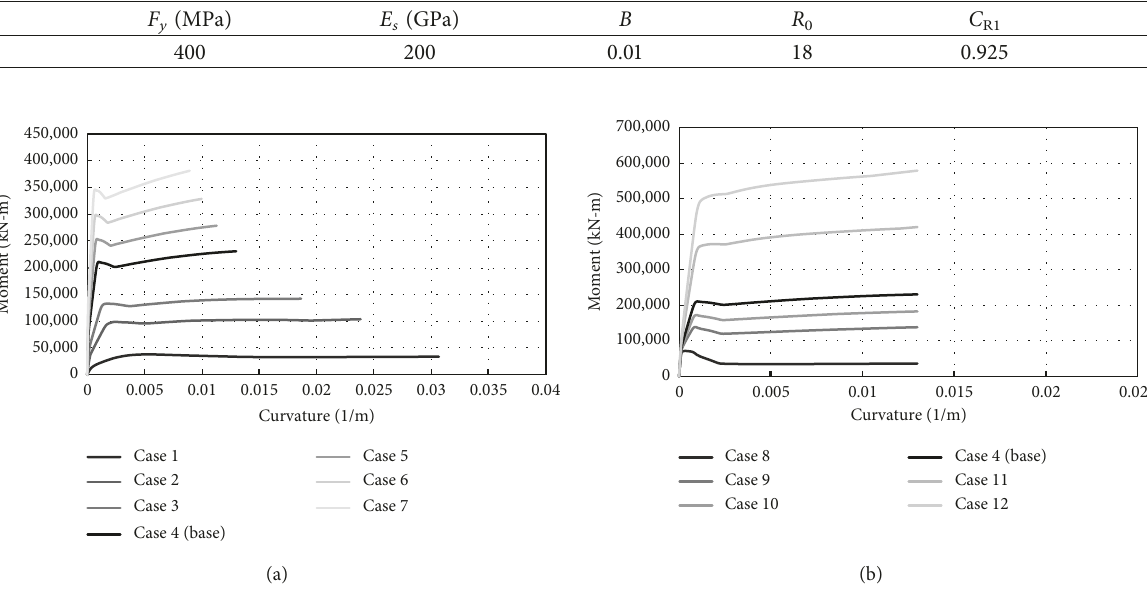
Figure 5: Hysteretic stress-strain behavior of (a) concrete02 and (b) steel02 . Table 2: Reinforcement steel properties.